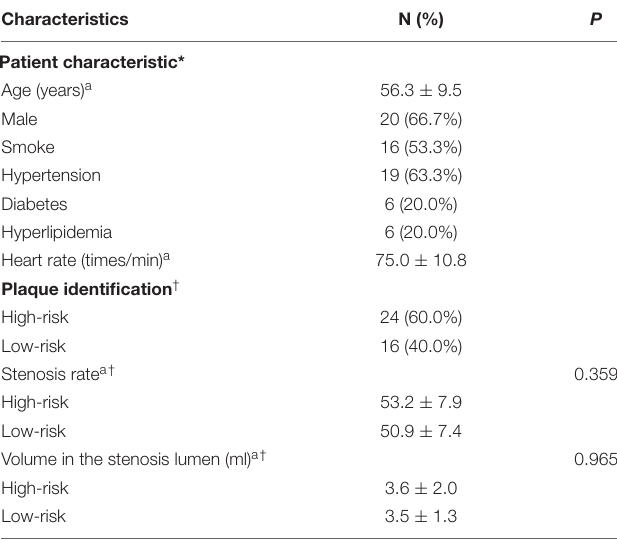
TABLE 1 | Patient demographic